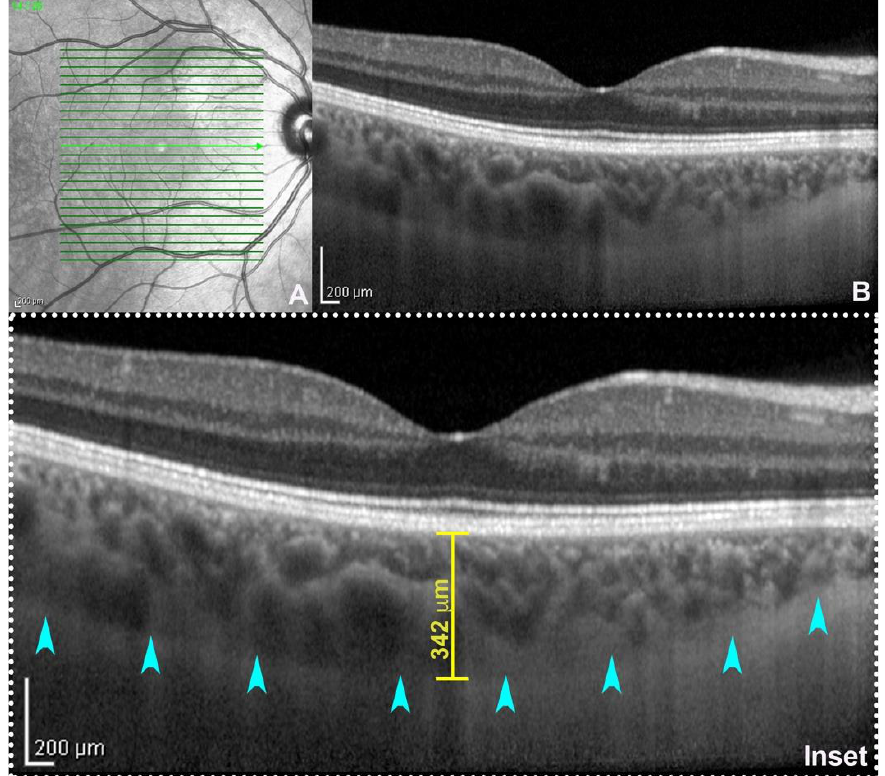
Figure 1. Enhanced depth imaging (EDI: ( A ) near-infrared reflectance; ( B ) spectral-domain optical coherence tomography (SD-OCT, Heidelberg Engineering, Germany) subfoveal B-scan acquired using EDI-mode. On magnification (inset), the choroid–scleral junction is clearly detectable (teal arrowheads) allowing the calculation of subfoveal choroidal thickness traced between the outer border of the retinal pigment epithelium and the inner surface of the choroid–scleral junction through a digital caliper.